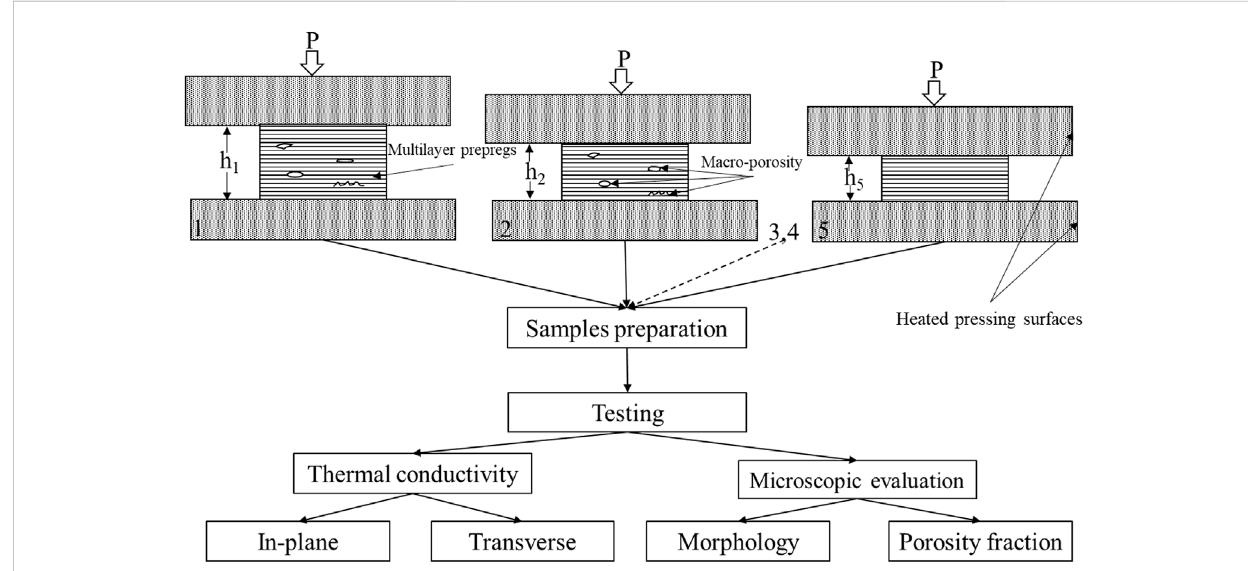
FIGURE 1 A schematic of a multi-step hot press compression process including steps 1 to 5 for the same load as a function of compacted thickness of consolidated fl ax/PP composites.